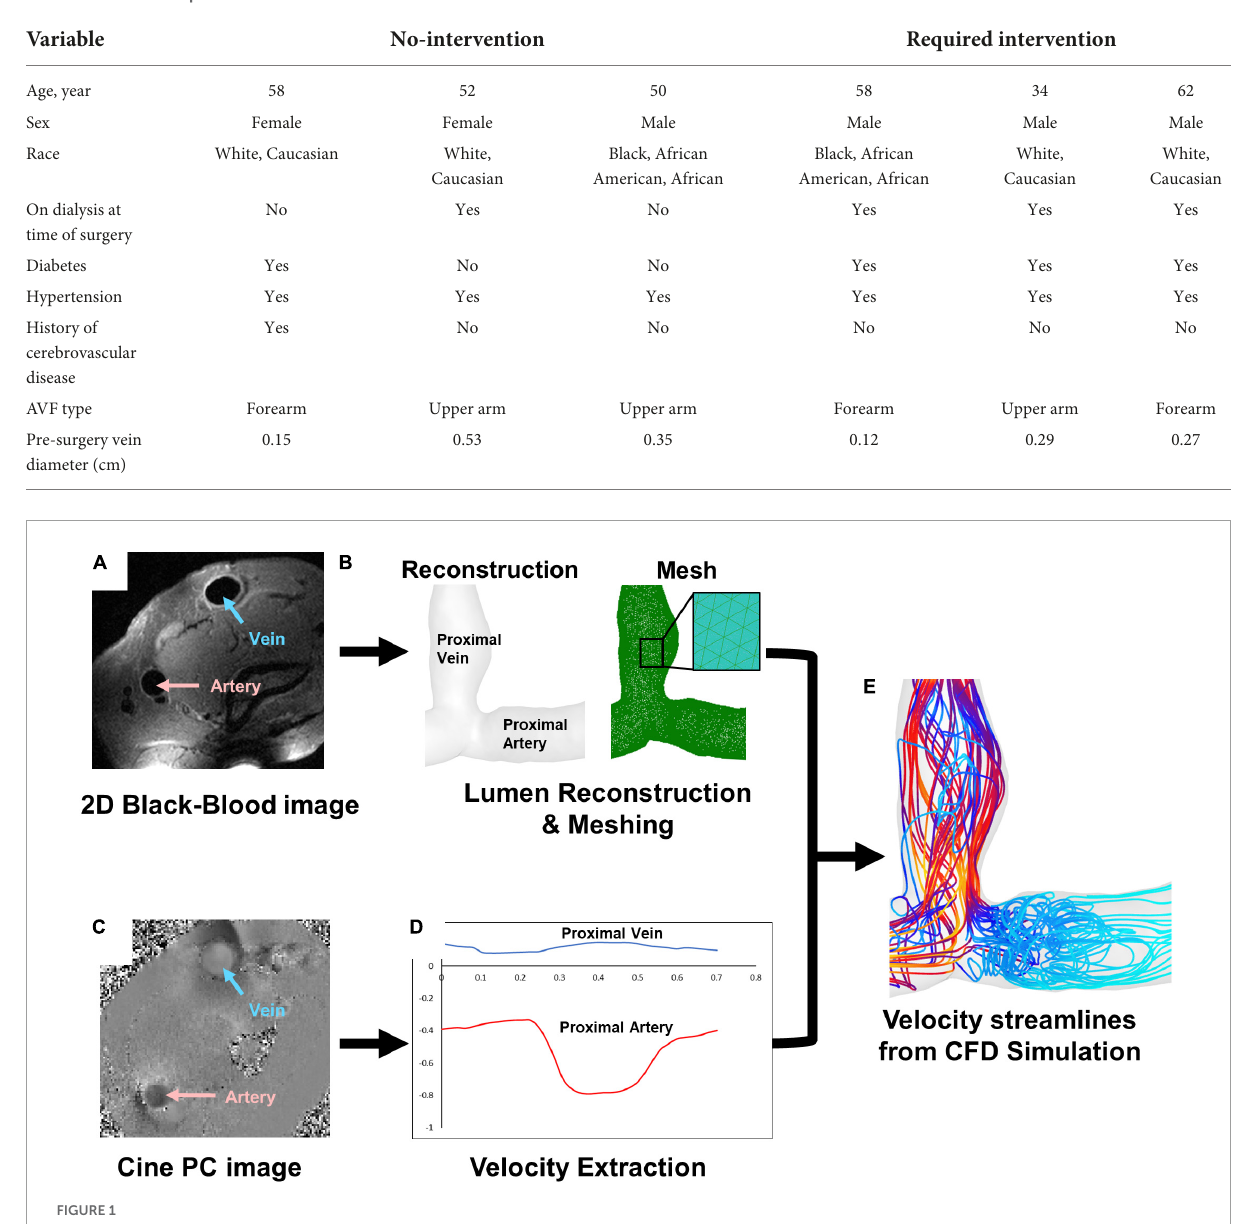
FIGURE1 Magnetic resonance imaging (MRI) and simulation pipeline. (A) 2D black-blood MRI scan for (B) lumen reconstruction and mesh. (C) Cine-phase contrast (PC) scan for (D) velocity extraction, which shows an example of velocity in the proximal vein (blue) and proximal artery (red) . (E) An example of velocity streamlines from CFD